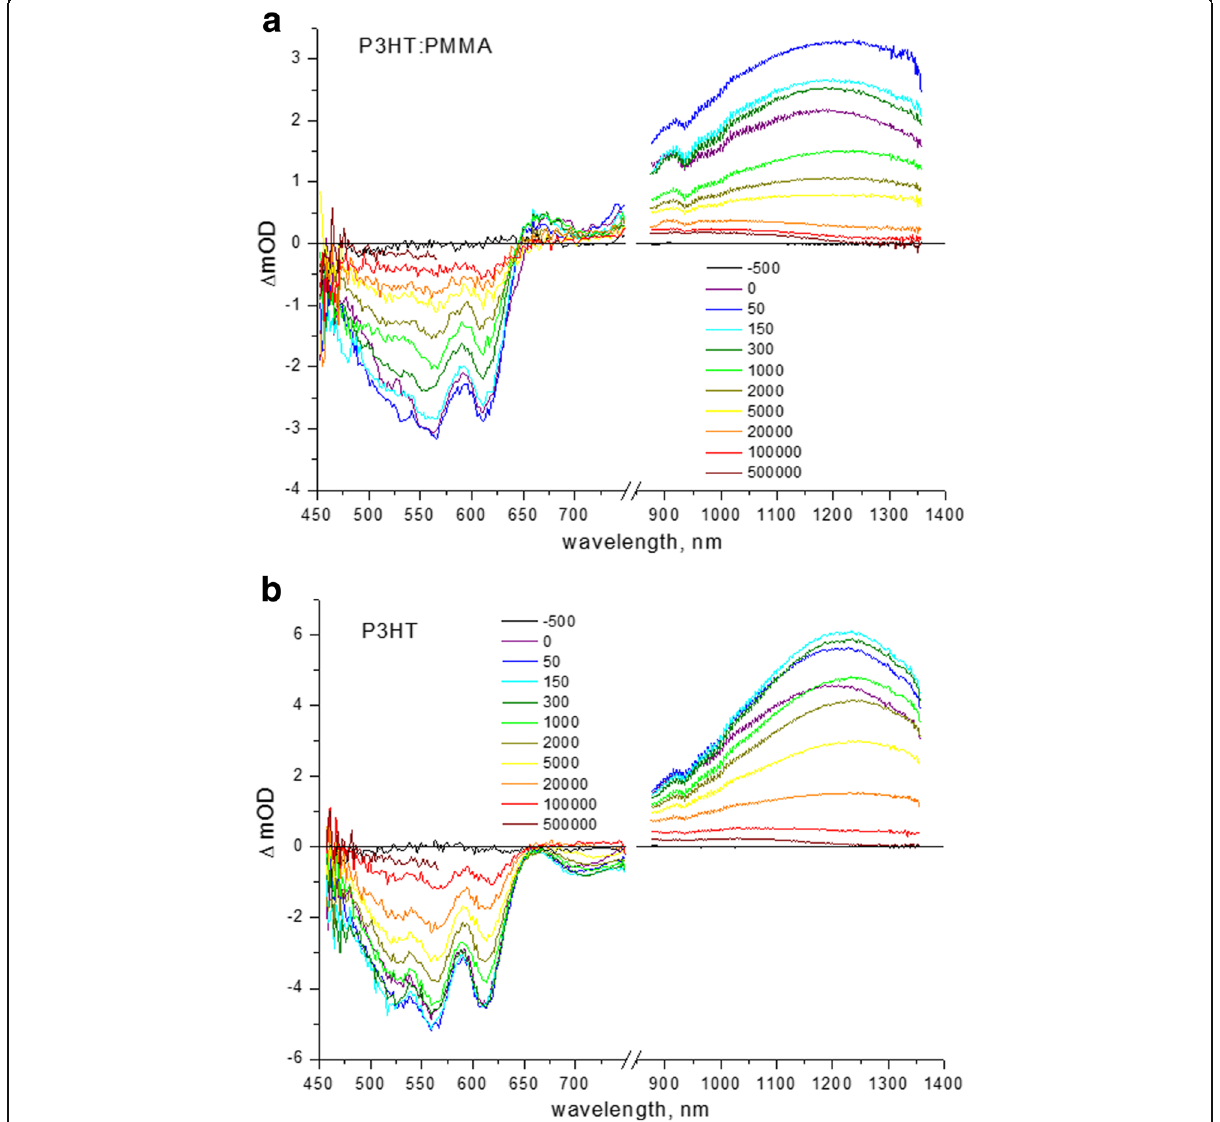
Fig. 3 TA spectra of a P3HT:PMMA (1:50 weight ratio) and b neat P3HT spin-coated films. Time delays are indicated in femtoseconds in the vertical bars